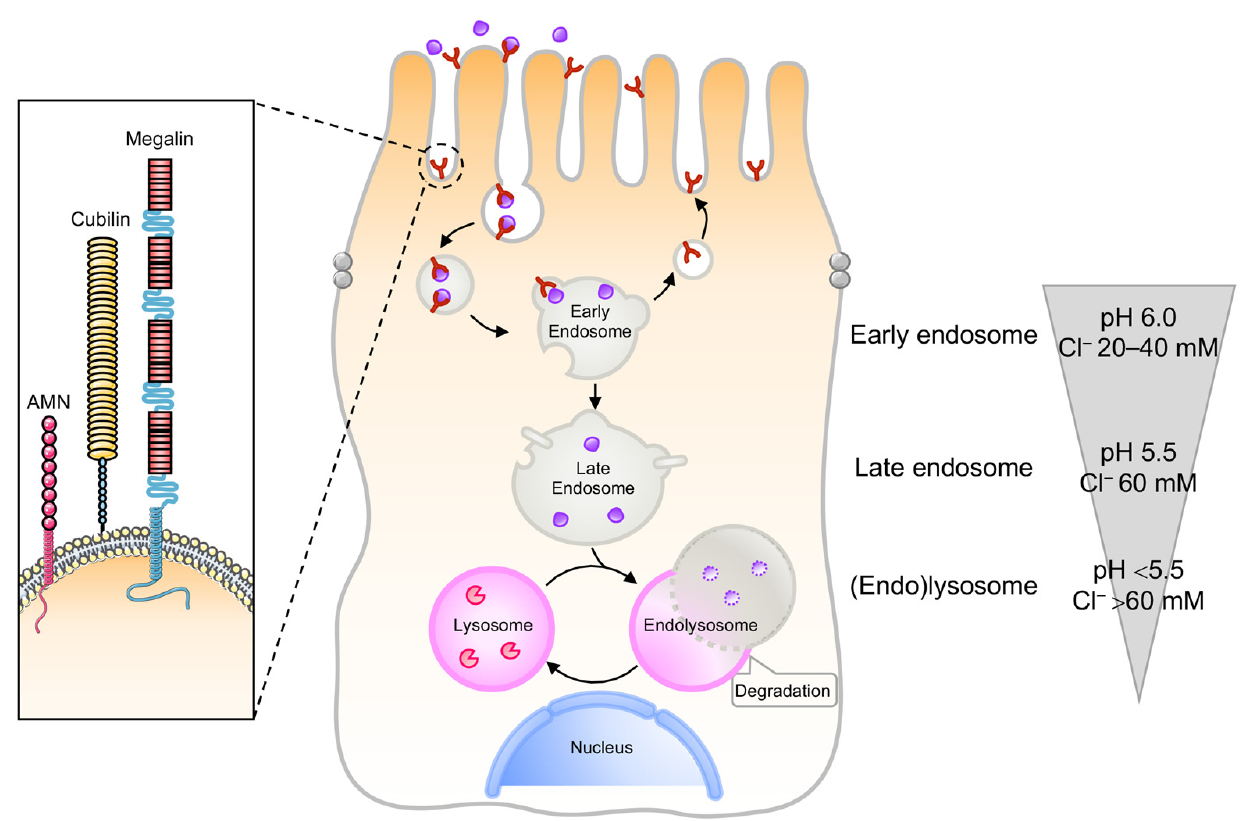
Figure 1. The endolysosome system in the kidney PT. Epithelial cells lining the kidney PT have multifunctional endocytic receptors and a highly developed endolysosome system to take up plasma proteins that are filtered by the glomerulus. The endocytic pathway in PT cells requires coated pits and vesicles, followed by early endosomes that form recycling endosomes or mature to late endosomes that fuse with the lysosome to form the endolysosomes. The luminal pH drops from 7.4 in the tubule lumen to 6.0 in early endosomes, 5.5 in late endosomes, and below 5.0 in endolysosomes. Such vesicular acidification enables the dissociation between receptors and their ligands, the recycling of receptors back to the apical membrane, and the progression of ligands towards the endolysosomal compartments. In parallel, the Cl − concentrations drop from 110 mM in the extracellular space to 20–40 mM in early endosomes, 60 mM in late endosomes, and >80 mM in lysosomes,